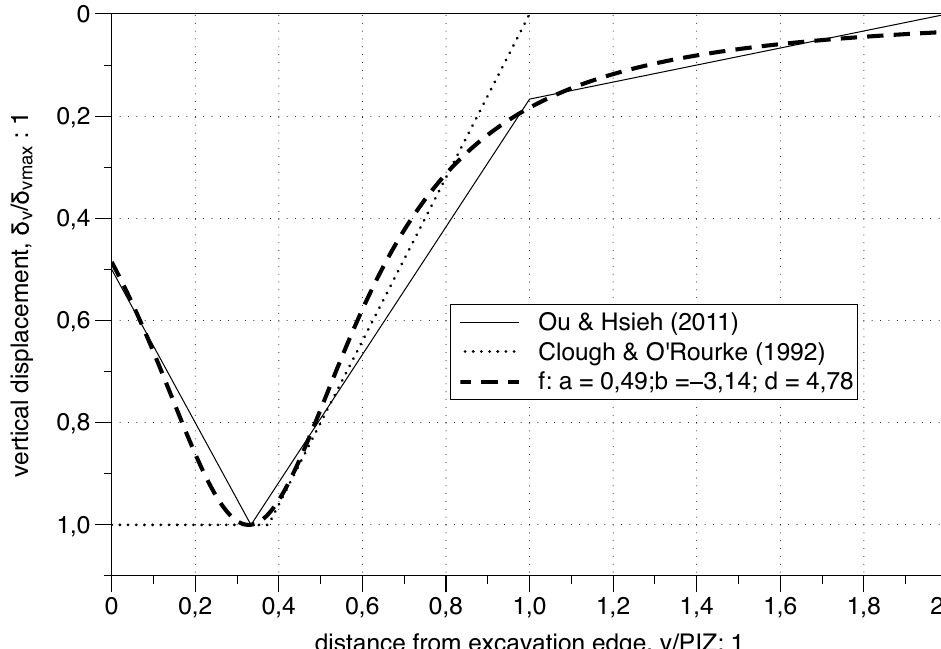
Figure 4. Concave settlement profiles.